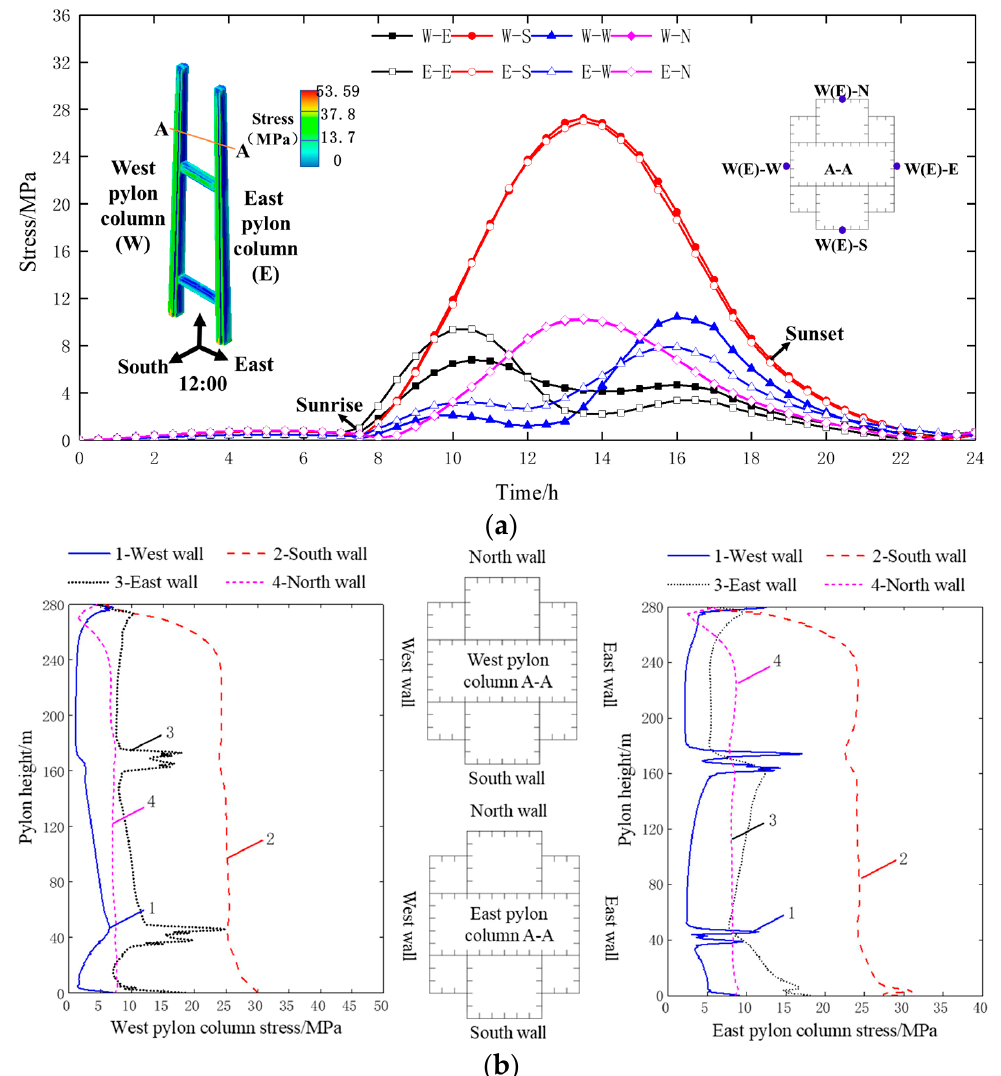
Figure 18. Stress curve of pylon in winter: ( a ) Thermal Stress curve of cross-section A-A; ( b ) Vertical stress distribution of bridge pylon at 12:00.